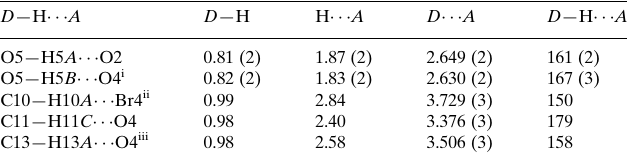
Hydrogen-bond geometry (A˚ , (cid:3)